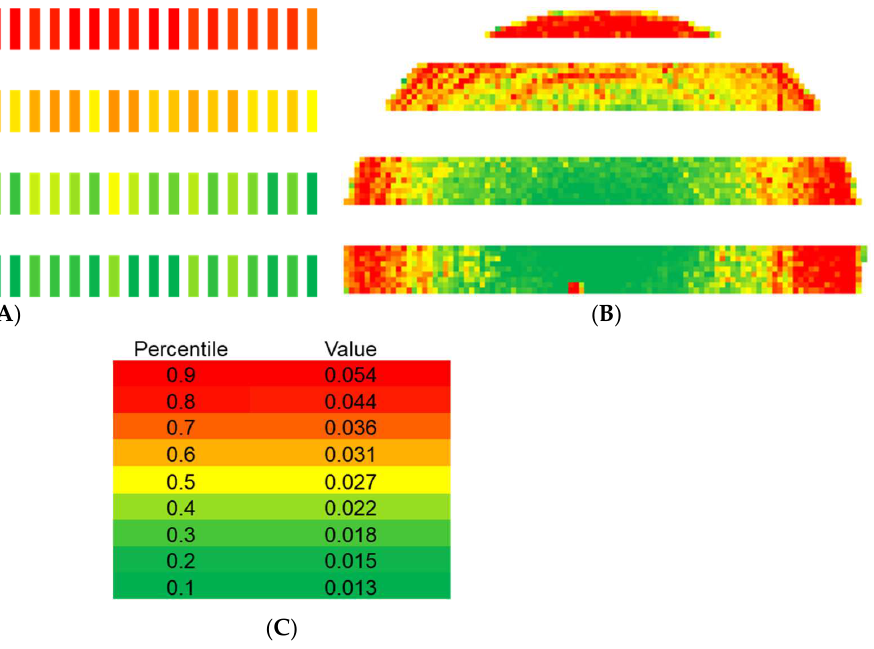
Figure 36. Distribution of precision (measurement range) for the ( A ) Velodyne ® HDL–32E and ( B ) Livox ® Mid–40 across their fields of view, ( C ) colorized by respective percentiles.